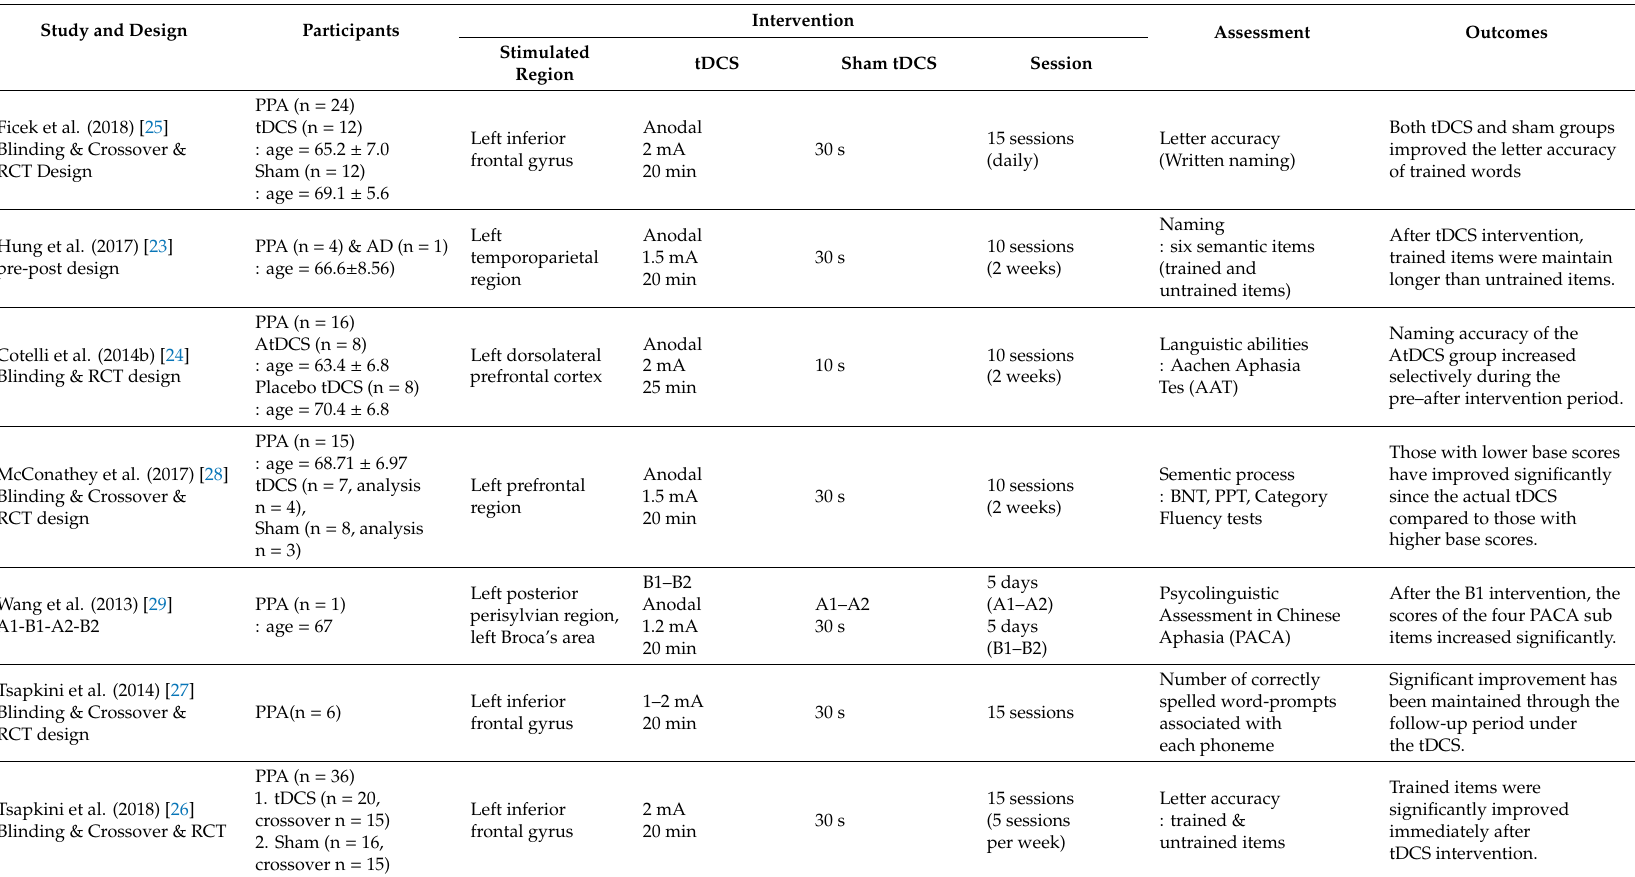
Table 2. The e ff ects of tDCS on naming improvement for